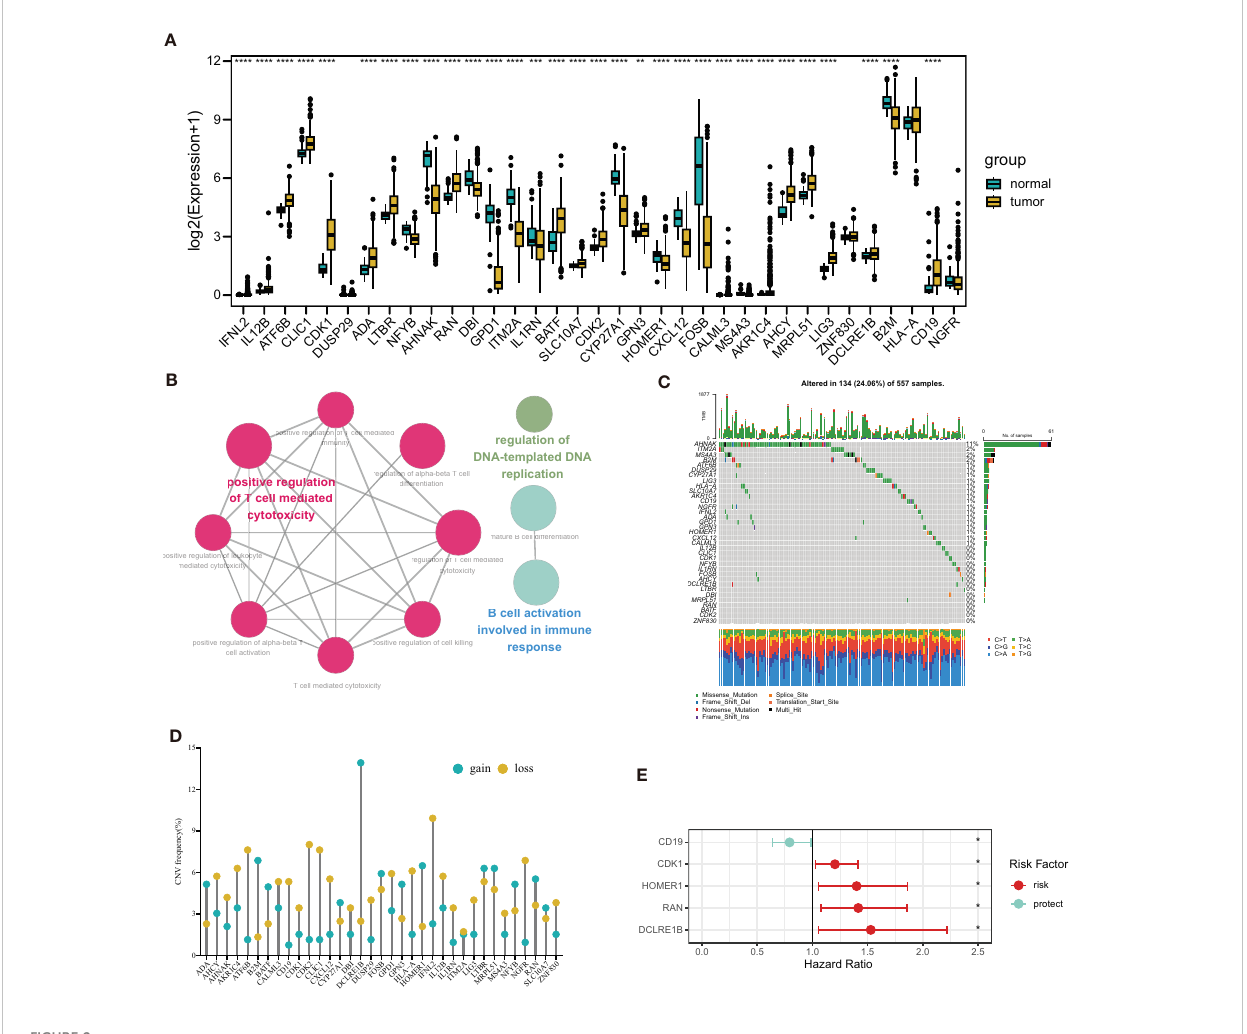
FIGURE 2 Landscape of T cell proliferation-related regulator genes (TPRGs) in LUAD. (A) Differentially expressed TPRGs in normal tissue and tumor tissue. (B) Potential biofunctional network associated with TPRGs from the STRING platform. (C) Mutation waterfall plots of 557 LUAD patients from the TCGA-LUAD cohort. (D) Copy number variation (CNV) frequency of TPRGs in the TCGA-LUAD cohort. (E) Hazard ratios (HR) forest plot of 5 TPRGs with prognostic values. HR > 1 (red) represents risk factors. HR (blue)< 1 represents protection factors. * P < 0.05, ** P < 0.01, *** P < 0.001 and **** P <